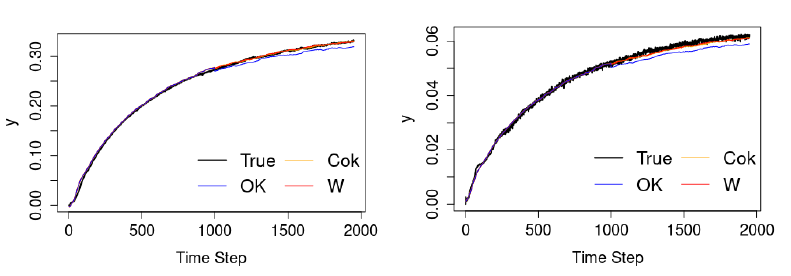
Figure 11. Changes in pollutants at one point in the Bai River over the whole time span.